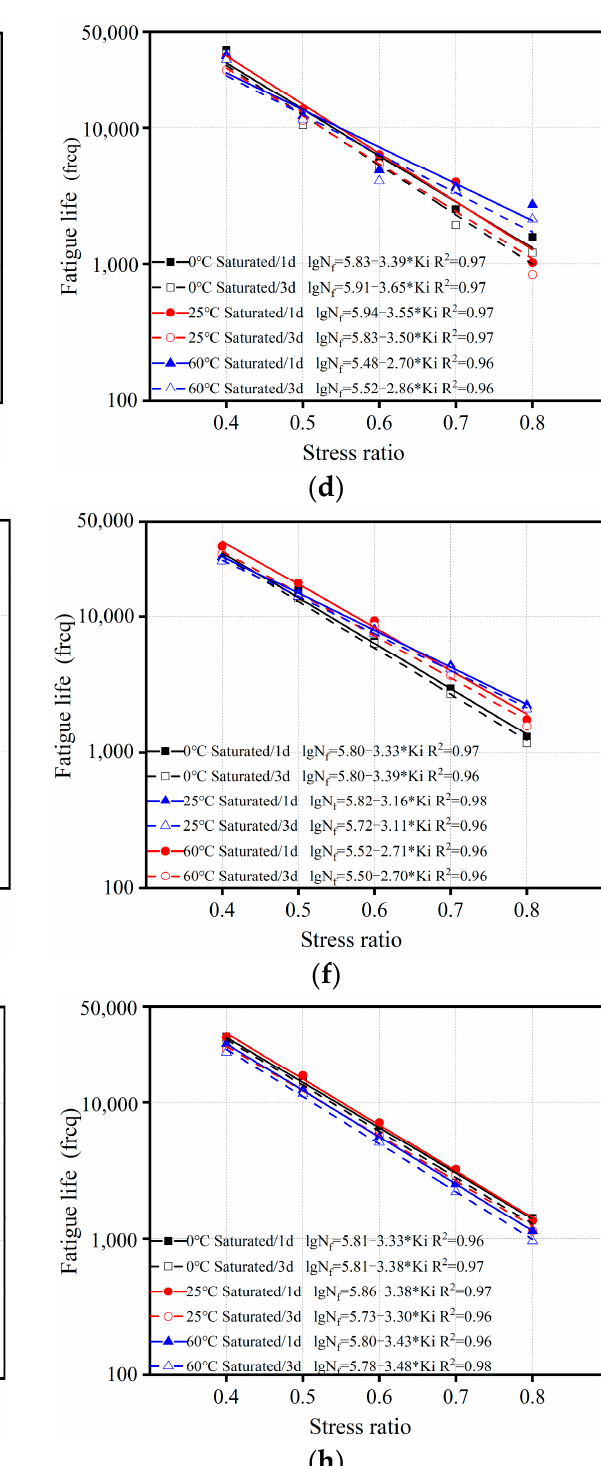
Figure 10. Fatigue life of the asphalt mixtures before and after water saturation (stress ratio = ratio of actual applied load to maximum SCB peak failure load). ( a ) Mineral powder—dry and H 2 O saturation, ( b ) Mineral powder—after H 2 O saturation, ( c ) Cement—dry and H 2 O saturation, ( d ) Cement—after H 2 O saturatioI ( e ) Slaked lime—dry and H 2 O saturation, ( f ) Slaked lime—after H 2 O saturation, ( g ) Brake pads—dry and H 2 O saturation, ( h ) Brake pads—after H 2 O saturation. ( * is the multiplica- tion sign in mathematical